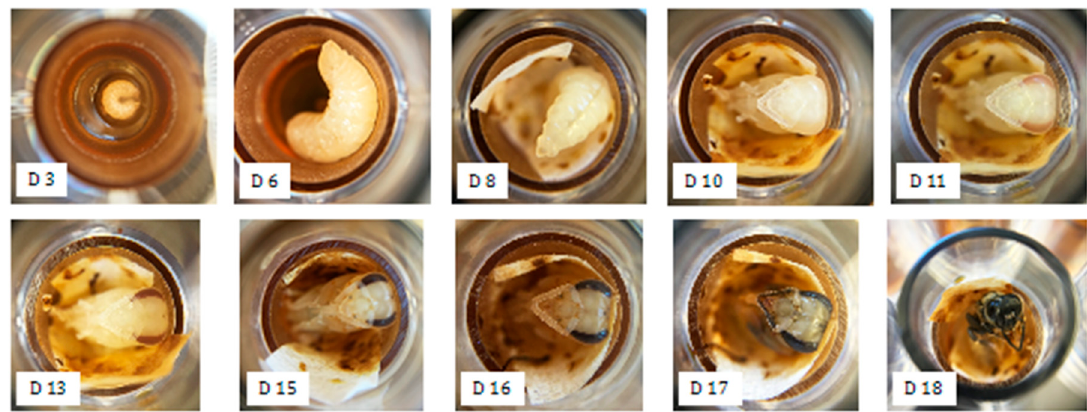
Figure 2. Photos of honey bee larval development reared in vitro. “D” corresponds to days after larval transfer.